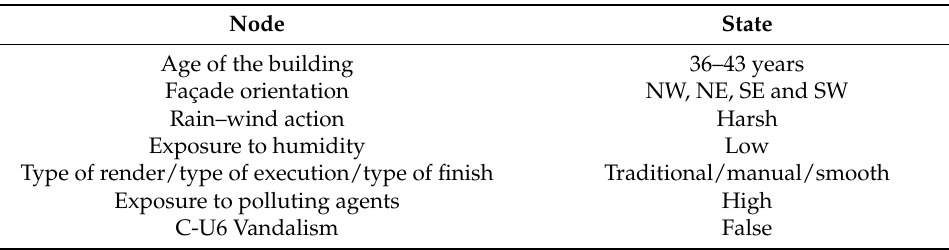
Table 5. Evidence for nodes related to the characteristics of the building, the façade and their exposure conditions, as well as cause C-U6.